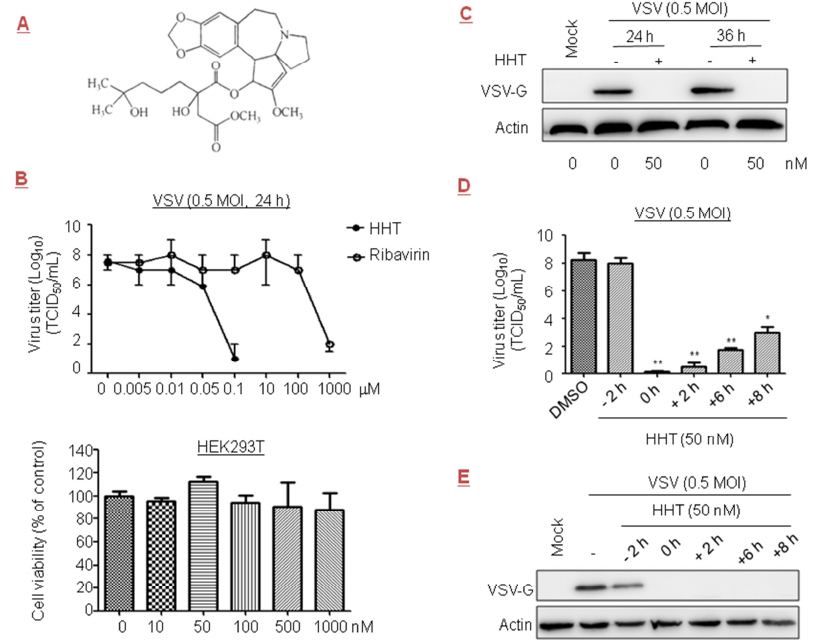
Figure 1. Inhibitory effect of homoharringtonine (HHT) on vesicular stomatitis virus (VSV) infection. ( A ) Chemical structure of HHT. ( B ) Dose-dependent studies. HEK293T cells seeded at 2.5 × 10 6 cells per well in standard six-well plates were infected with VSV at 0.5 multiplicity of infection (MOI) in the presence of HHT or ribavirin at different concentrations for 24 h. HHT and ribavirin were dissolved in phosphate-buffered saline (PBS) containing 1% dimethyl sulfoxide (DMSO). Viral yields in the medium were determined by half maximal tissue culture infective dose (TCID 50 ). These experiments were performed two times with three replicates in each experiment. Values represent means and standard deviation (SD). Bottom, effects of HHT on cell viability. HEK293T cells were treated with various concentrations of HHT for 24 h, and cell viability was determined by 3-(4,5-dimethylthiazol-2-yl)-2,5-diphenyltetrazolium bromide (MTT) assay. These experiments were performed two times with three replicates in each experiment. Values represent means and SD. ( C ) HEK293T cells were mock infected or infected with VSV at 0.5 MOI in the presence of PBS or HHT of 50 nM. At 24 and 36 h post infection (h.p.i.), cell lysates were harvested and electrophoretically separated proteins were analyzed by immunoblotting with antibody to viral protein VSV-G, with actin as a control. ( D , E ) Time-of-addition study. HEK293T cells were exposed to VSV at 0.5 MOI, and treated with HHT at 50 nM at different time points before, simultaneously with, or after infection. At 48 h.p.i., viral yields in the medium were determined by TCID 50 . These experiments were performed two times with three replicates in each experiment. Values represent means and SD. Statistical analysis was evaluated by one-way analysis of variance with Dunnett’s multiple-comparison test. * p < 0.05; ** p < 0.01 compared to PBS-treated group ( D ). Under the same experimental conditions, electrophoretically separated proteins were analyzed by immunoblotting with antibodies to VSV-G and actin ( E